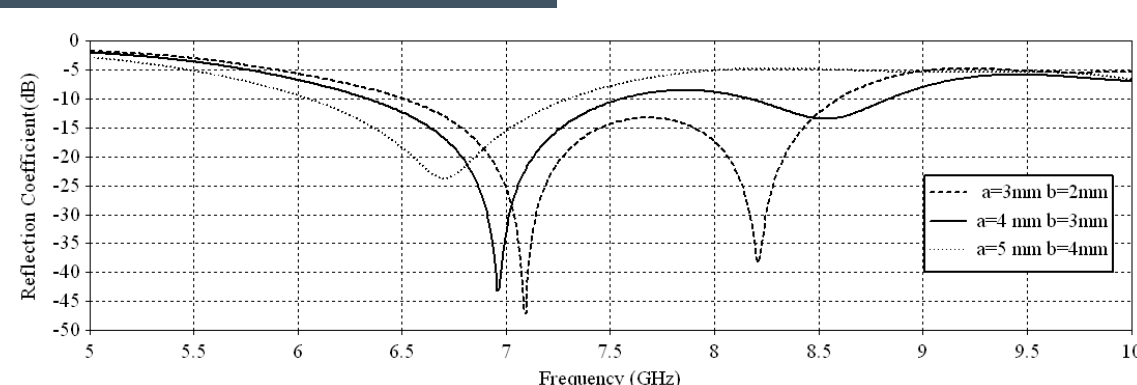
Figure 6. Effect of varying elliptical slot minor axis and major axis radius in patch on reflection coefficient as a function of frequency